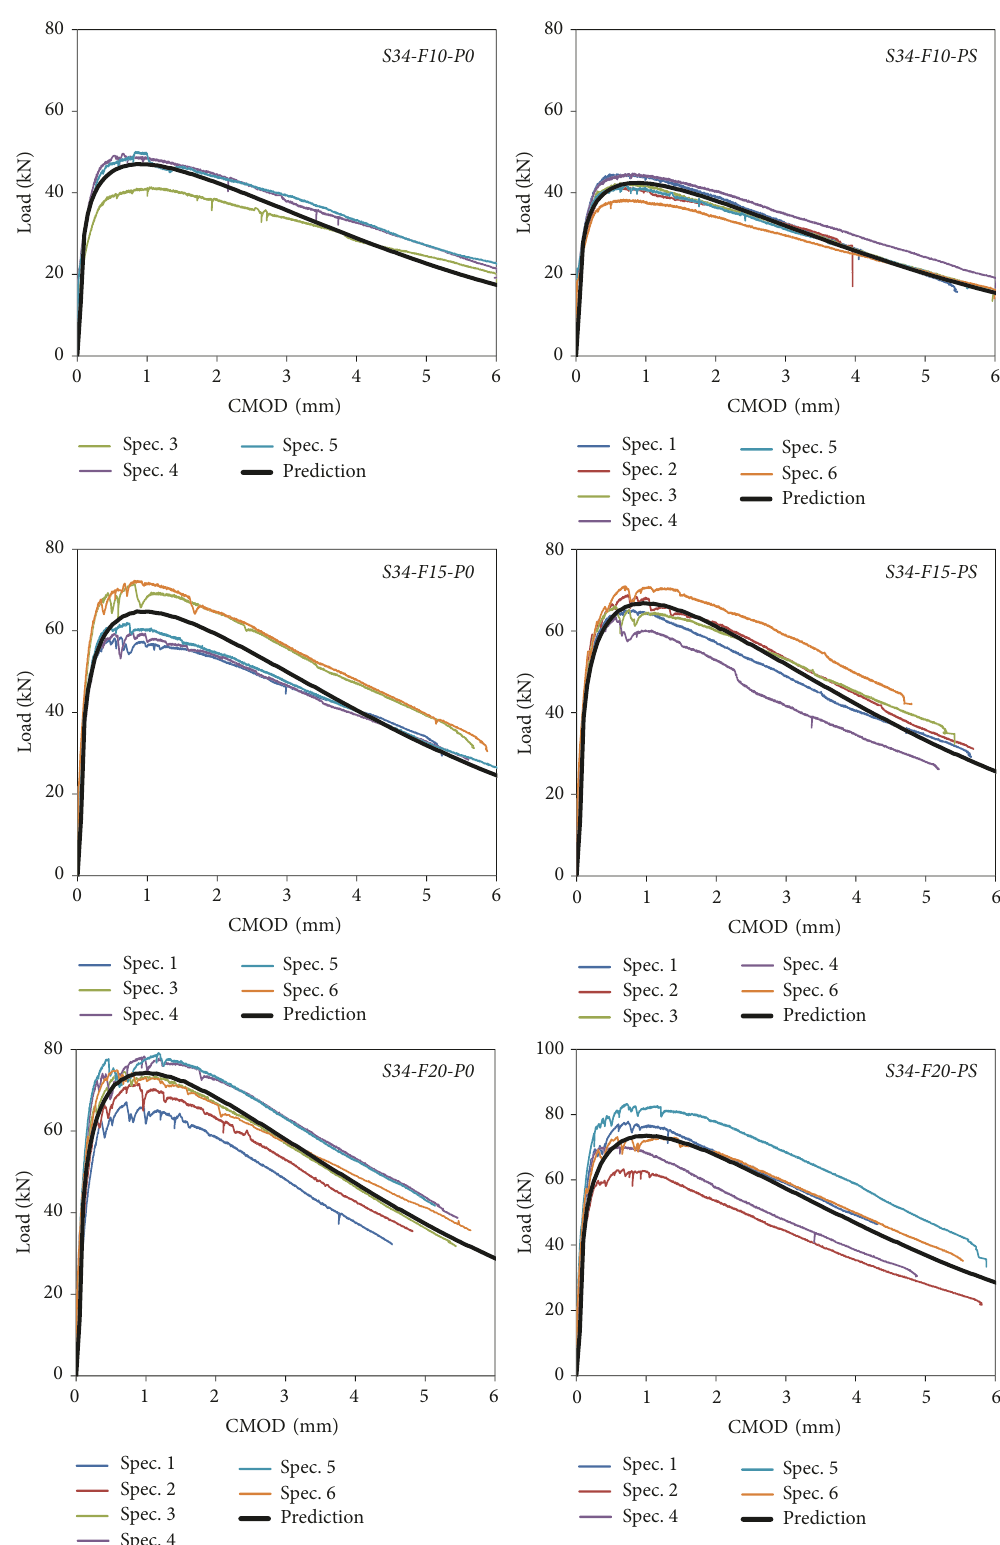
Figure 7: Comparison on the applied load-CMOD